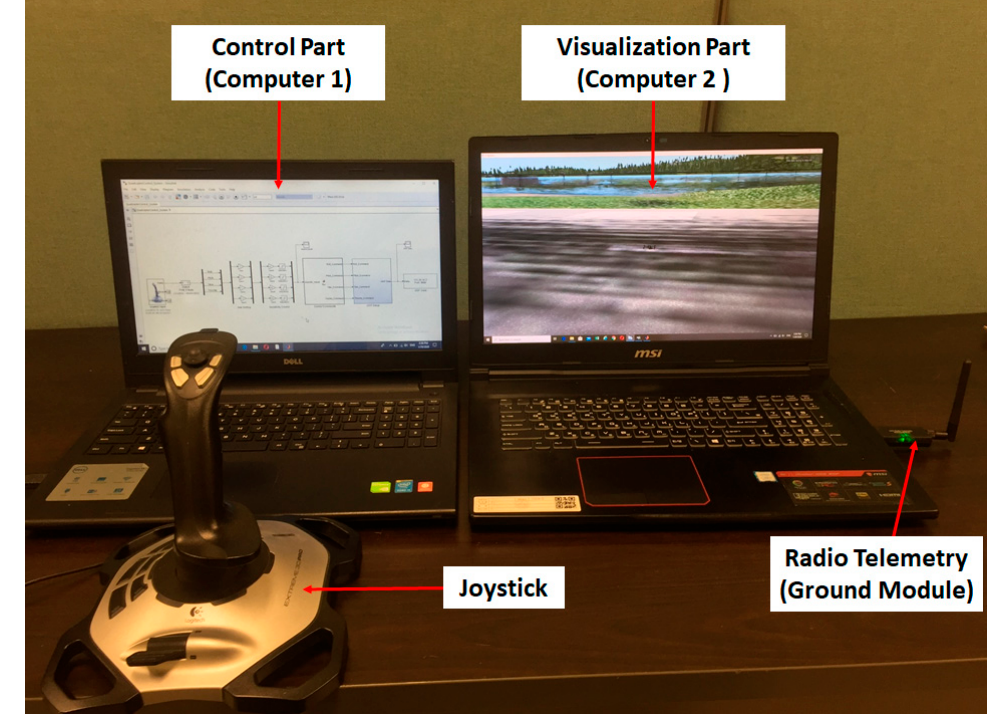
Figure 12. Visualized ground control station (GCS) setup.